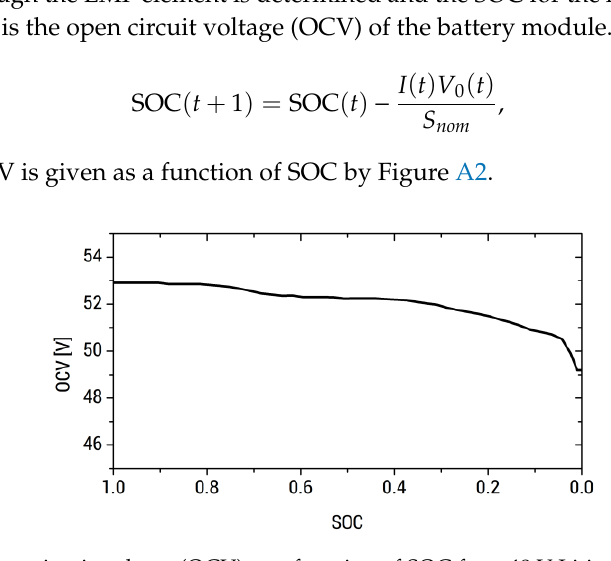
Figure A2. Open circuit voltage (OCV) as a function of SOC for a 48 V Li-ion battery